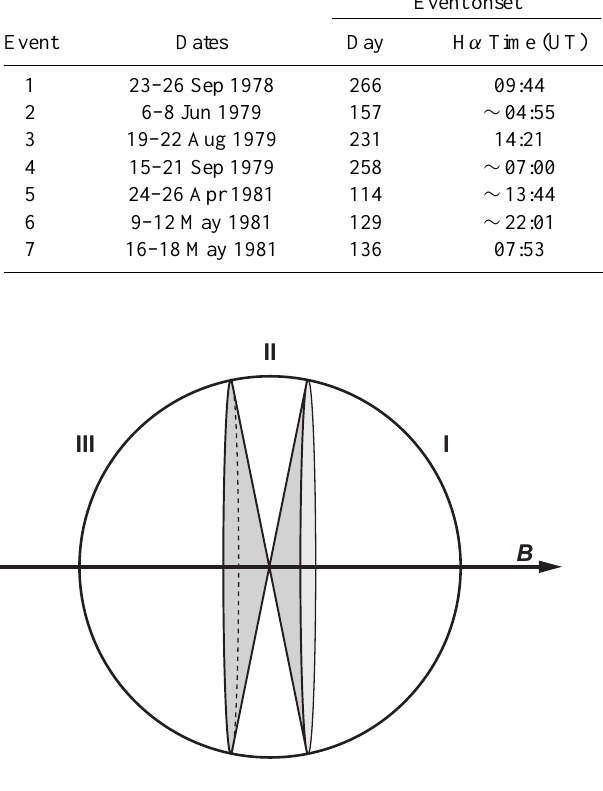
Fig. 14. Illustration of the three pitch angle scattering regions. I is the forward hemisphere of less than 90 ◦ pitch angles, and II is the narrow region near 90 ◦ , where resonant (small amplitude) wave- particle interactions do not take place. Region III is the backward propagating (sunward) pitch